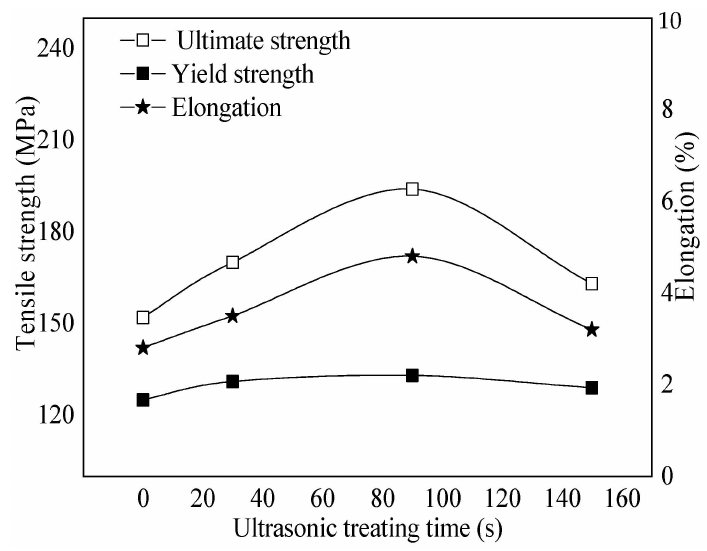
Figure 14. Variation of mechanical properties in AZ91 alloy by ultrasonic treating time.